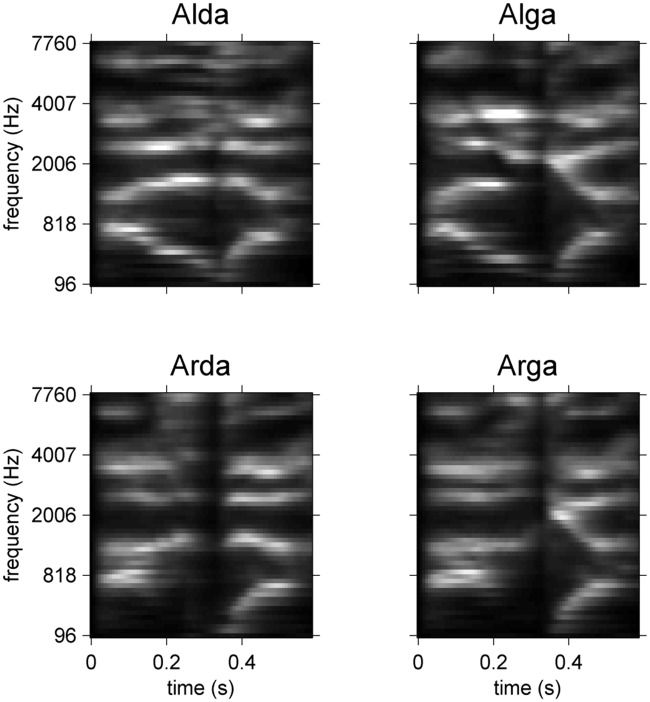
Cochleograms of the four stimuli involved in the experiment.Parameters for spectral and temporal resolution are identical to those used to derive the ACIs (see details in the main text).